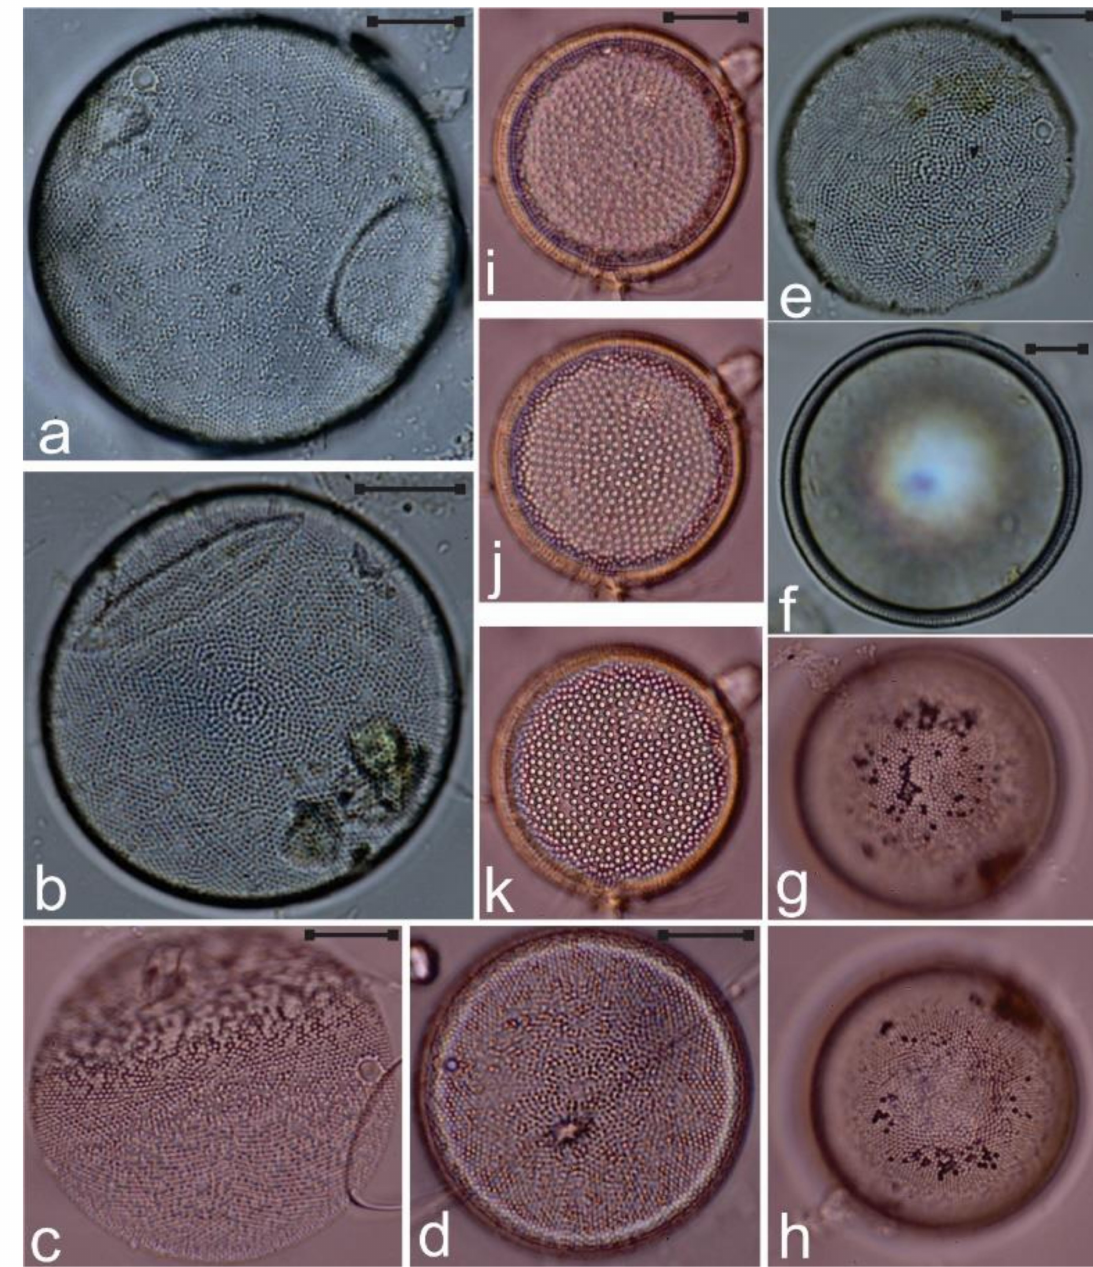
Figure 9. ( a – e ) Actinocyclus subtilis in di ff erent focal planes; ( f – h ) A. tenuissimus ; ( i – k ) A. ochotensis . Scale bar = 10 µ